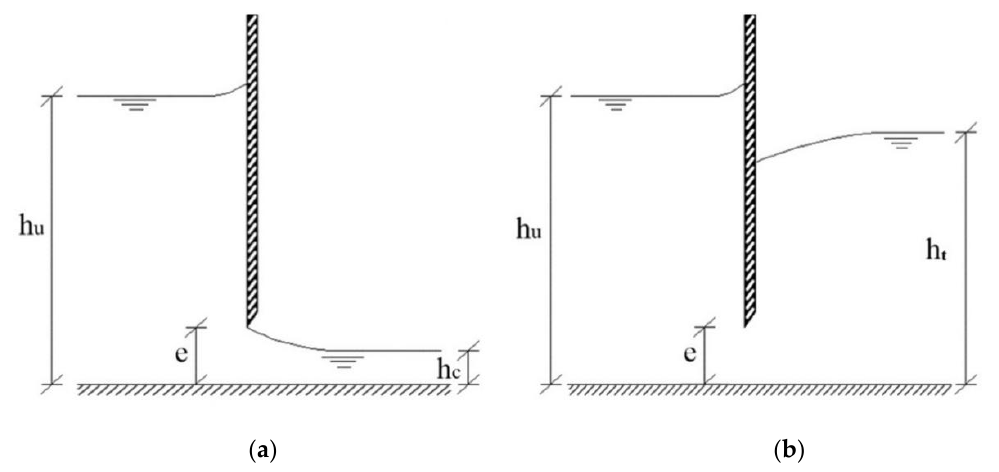
Figure 1. Flow through a sluice gate: ( a ) free-surface flow; ( b ) submerged flow.